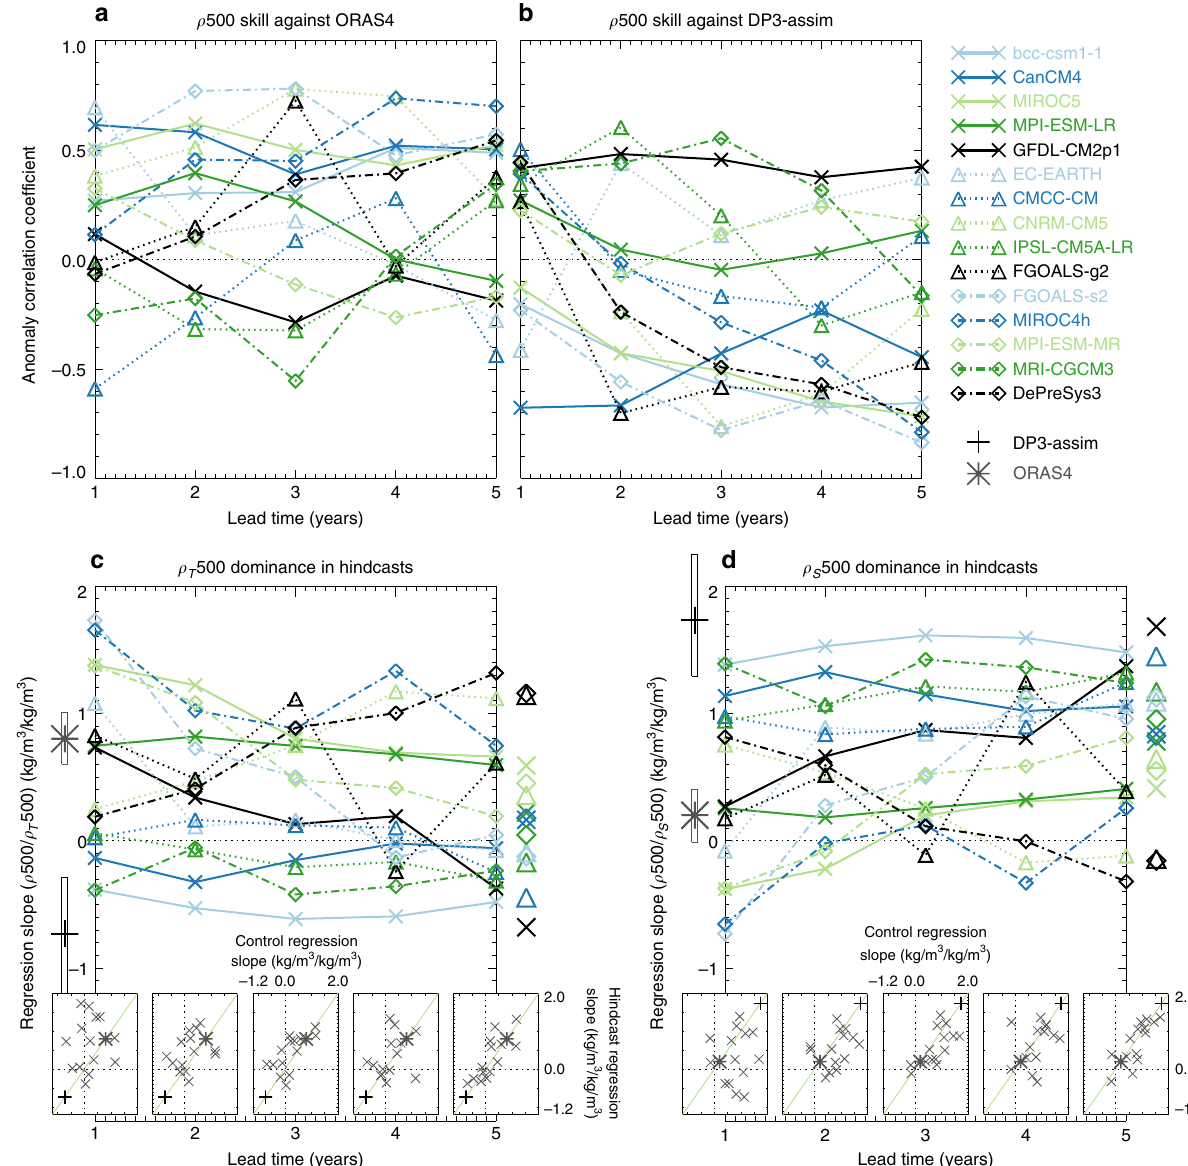
Fig. 2 The evolution of correlation skill and density drivers in the hindcasts. The correlation skill in the Labrador Sea top 500 m density ( ρ 500) between the hindcast systems and the reanalyses ORAS4 ( a ) and DP3-assim ( b ), as a function of lead time. A lead-time dependent bias correction (assessed against ORAS4 and DP3-assim separately) is applied to the hindcasts before calculating the skill. The regression slope between ρ 500 and ρ T 500 ( c ), or ρ 500 and ρ S 500 ( d ) in the hindcast systems as a function of lead time. For comparison, the same regression slope in ORAS4 (grey star) and DP3-assim (black cross) is displayed to the left of the axes with 90% con fi dence intervals (boxes), estimated via a bootstrap analysis. In addition, the same regression slope calculated from the control simulations (see Table 1) is shown to the right of the axes (further investigation of the stationarity of the control regression coef fi cients is shown in Supplementary Fig. 4). Finally, scatter plots of control simulation regression slope ( x -axis, constant) against hindcast regression slope ( y -axis) are inlaid as a function of lead time to highlight how the hindcasts revert to the nature described by the control simulations within a few years. The reanalyses are also shown with symbols coloured as before and can be seen to span a large portion of the hindcast behaviour. The one-to-one line is shown in